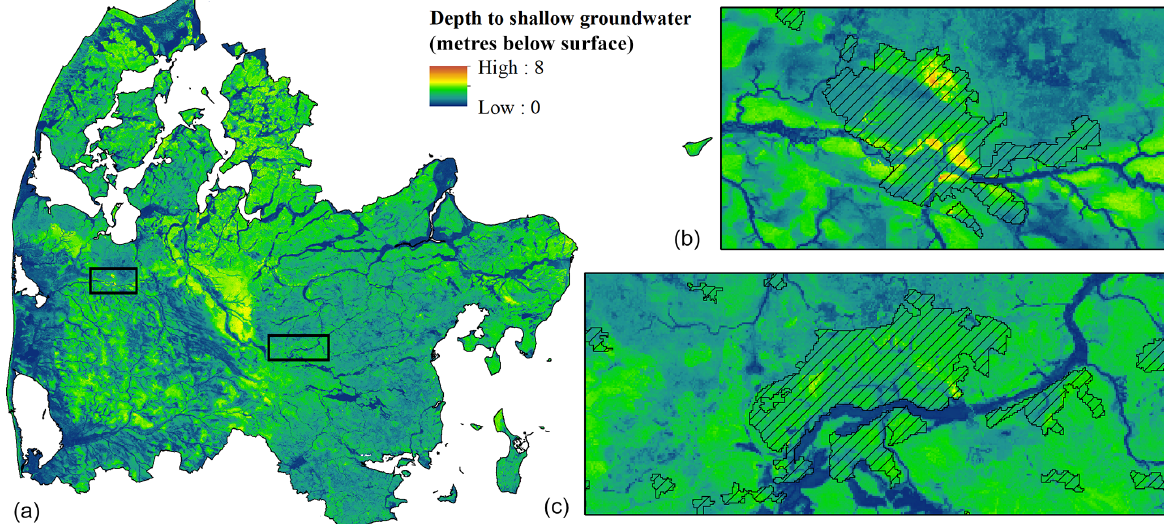
Figure 4. The resulting map of the depth to the shallow water table at a 50m grid resolution. The zoomed-in extents highlight two urban areas. Panel (b) displays the city of Holstebro, and panel (c) depicts the city of Silkeborg. Urban areas are visualized using